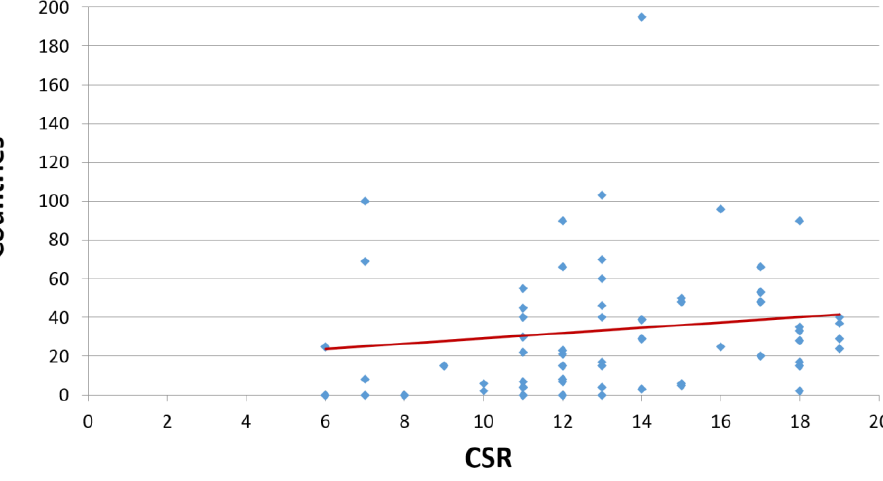
Figure 3. Relationship between CSR and COUNTRIES.